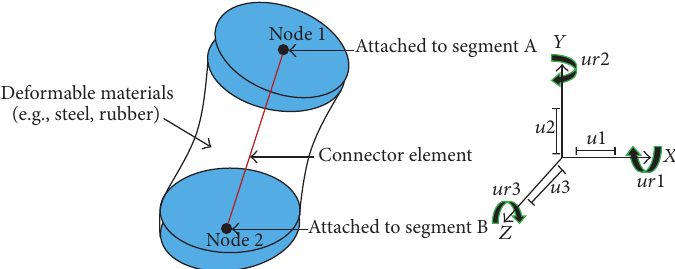
Figure 6: Schematic diagram of “bushing” and the relative motion between the two ends of the connector element.